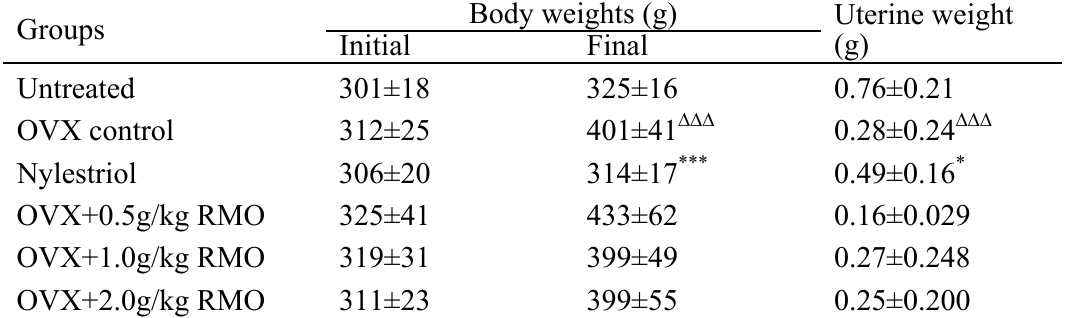
Table 1. Comparison of body and uterine weight among groups (n=10)